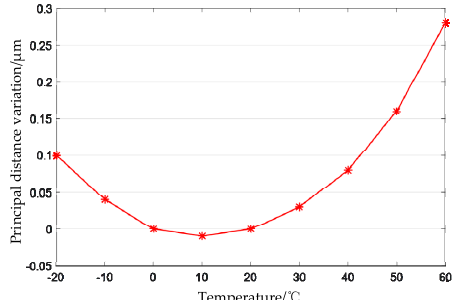
Figure 8. Variation of principal distance with temperature.